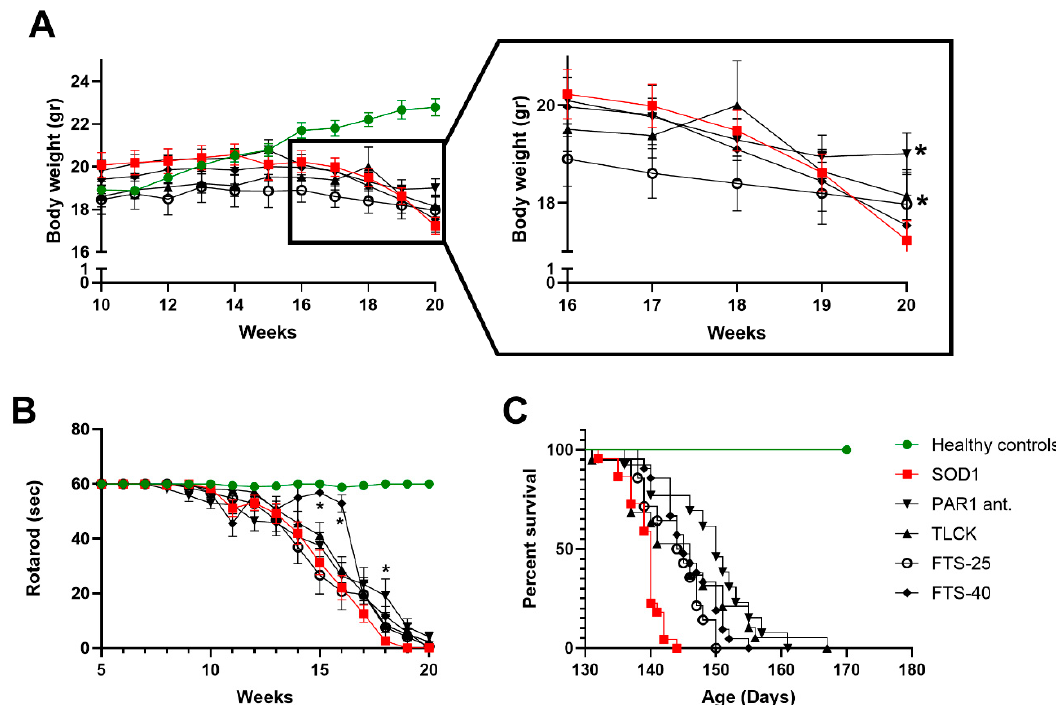
Figure 3. Body weight, rotarod and survival outcomes of SOD1 mice with various treatment: ( A ) healthy control mice progressively gain weight, while SOD1 mice gain weight up until the age of 11 weeks. Following a plateau, at the age of 17 weeks, SOD1 mice show progressive weight loss. A significant di ff erence in body weight is measured between healthy control and SOD1 mice. This di ff erence persists throughout the remaining experiment duration ( p < 0.0001). In the insert, an enlargement of weeks 16–20 is presented. All treatments show a beneficial e ff ect on weight loss. Number of animals: healthy control n = 6, SOD1 n = 22, N -Tosyl-Lys-chloromethylketone (TLCK) n = 21, PAR1 antagonist n = 14, S-trans-trans-farnesylthiosalicylic acid (FTS-40) n = 21, FTS-25 n = 14; ( B ) SOD1 mice show shorter rotarod scores starting at the age of 14 weeks and subsequently thorough the experiment ( p < 0.0001). FTS-40 improves rotarod scores at weeks 15 and 16 ( p < 0.01). Number of animals: Healthy control n = 5, SOD1 n = 21, TLCK n = 20, PAR1 antagonist n = 14, FTS-40 n = 5, FTS-25 n = 13; ( C ) Survival is significantly improved by all treatments except for high-dose FTS ( p < 0.01). Number of animals: Healthy control n = 6, SOD1 n = 22, PAR1 antagonist n = 13, TLCK n = 19, FTS-25 n = 14, FTS-40 n = 21, FTS-60 n = 19. * p < 0.05.